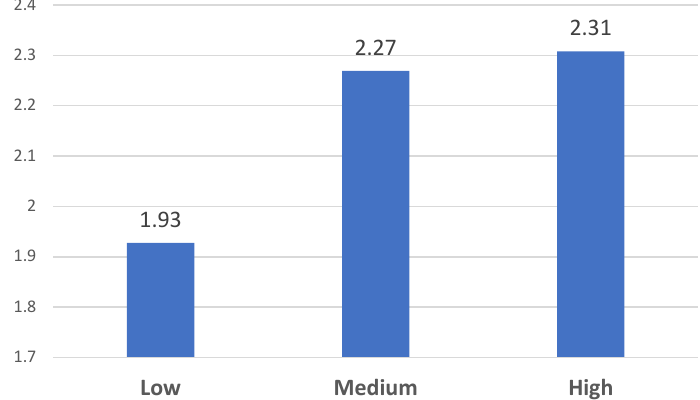
Figure 1. Levels of FoMO 1 differences based on perceived phubbing levels.